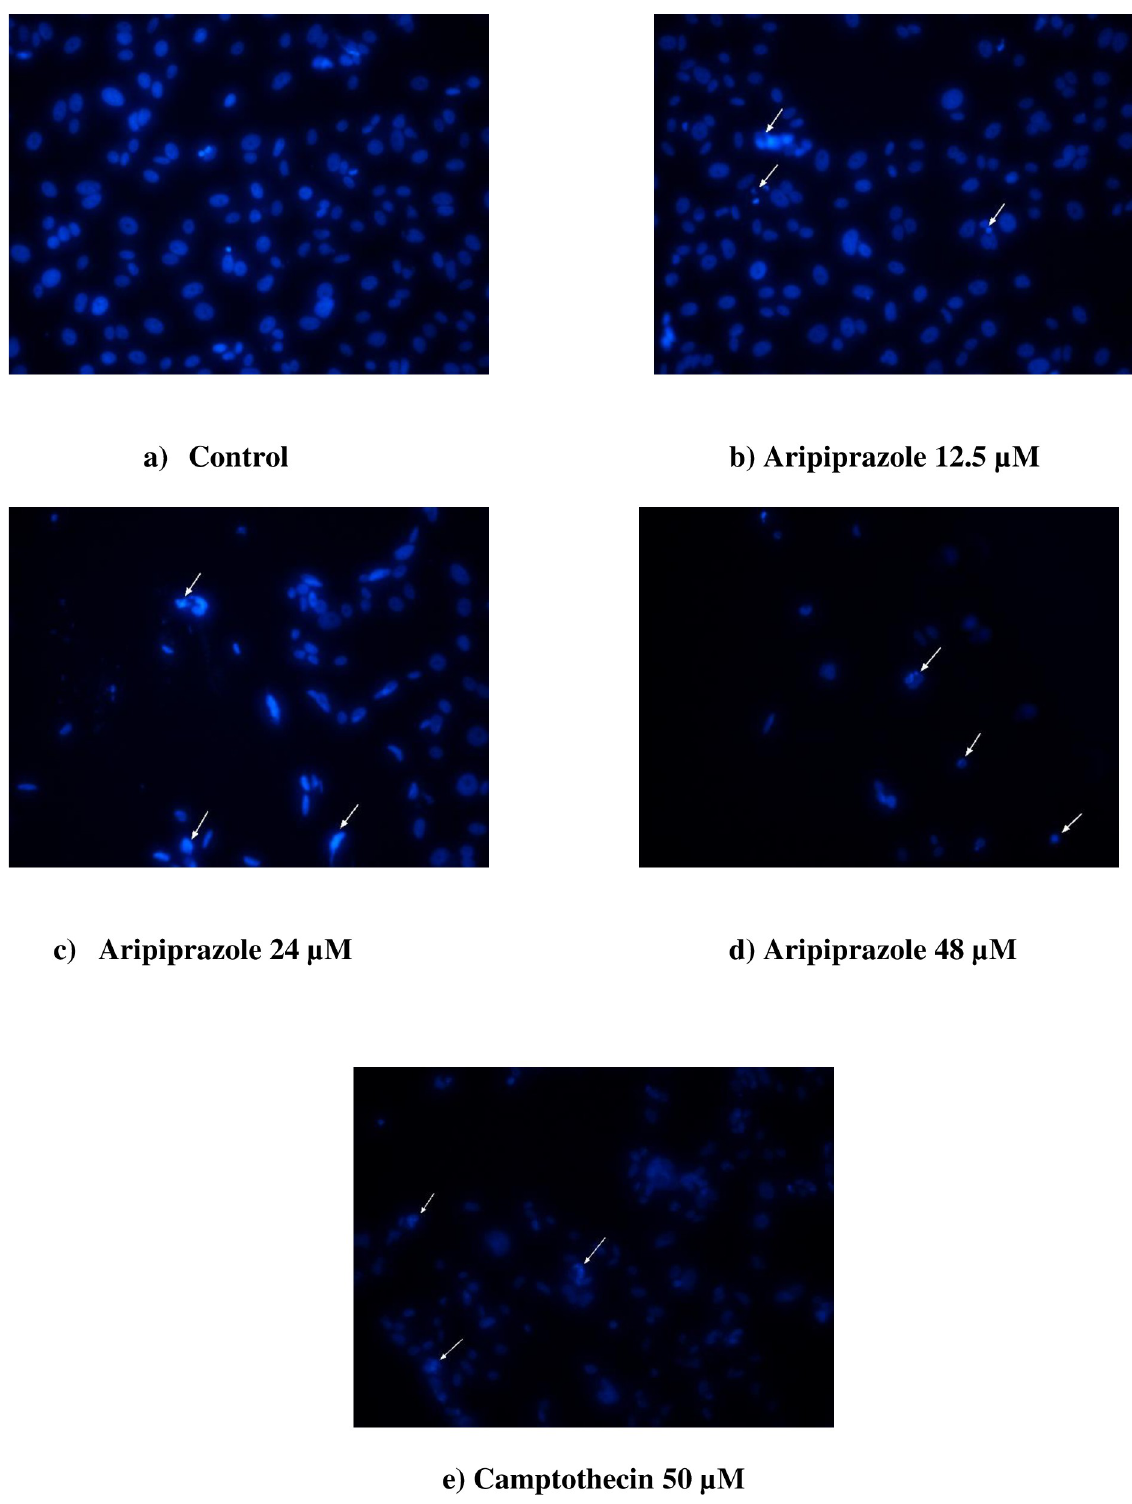
Fig 5. Analysis of aripiprazole-induced apoptosis in MCF-7 breast cancer cells by DAPI. a) control (untreated MCF-7), b) aripiprazole 12.5 μ M, c) aripiprazole 24 μ M, d) aripiprazole 48 μ M, and e) camptothecin (50 μ M). Images were taken at 20X magnification by using microscope TE-2000, Nikon, Japan. The nuclei were stained with DAPI (blue).